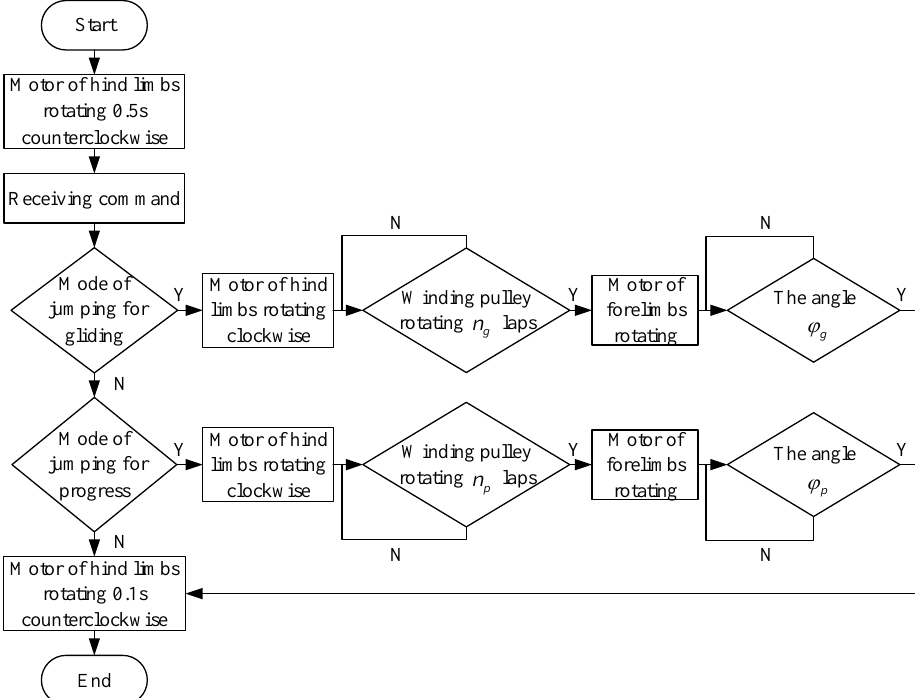
Figure 15. Workflow of the robot.